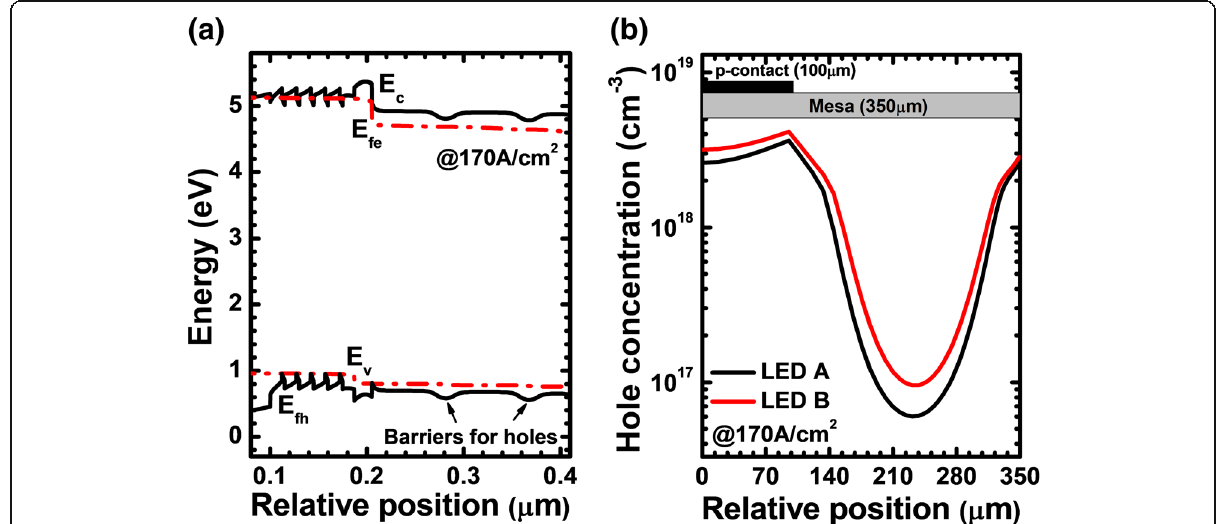
Fig. 3 a Energy band diagram for LED B at the current density of 170 A/cm 2 . E c , E v , E fe , and E fh denote the conduction band, the valance band, and quasi-Fermi levels for electrons and holes, respectively, b lateral hole distribution in the last quantum well for LEDs A and B at the current density of 170 A/cm 2 , respectively